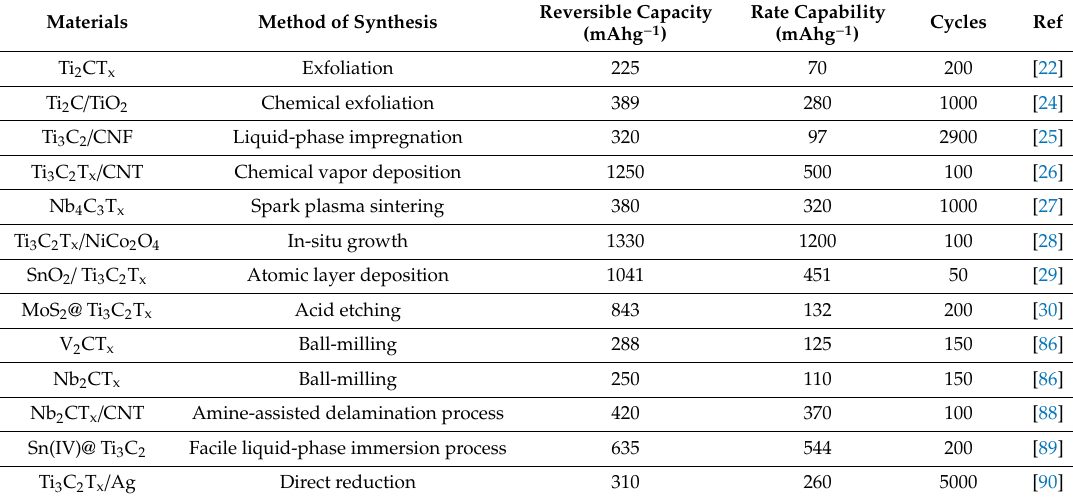
Table 2. Overview of electrochemical characteristics from MXene and MXene-based composite for